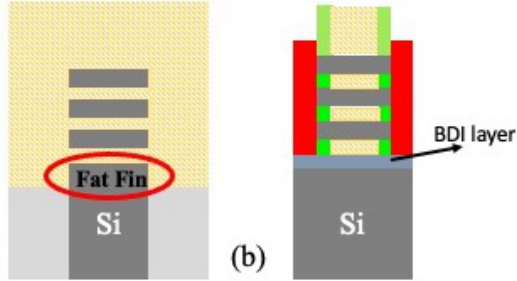
Figure 3. ( a ) A figure depicting a cross-fin cut showing high-k metal gate extension beyond the bottom sheet due to poor process control. As the metal depth below the bottom device increases, the performance penalty due to increased C ef fective also increases. ( b ) A figure showing improved process control due to full bottom dielectric isolation (FBDI) in the source/drain region.